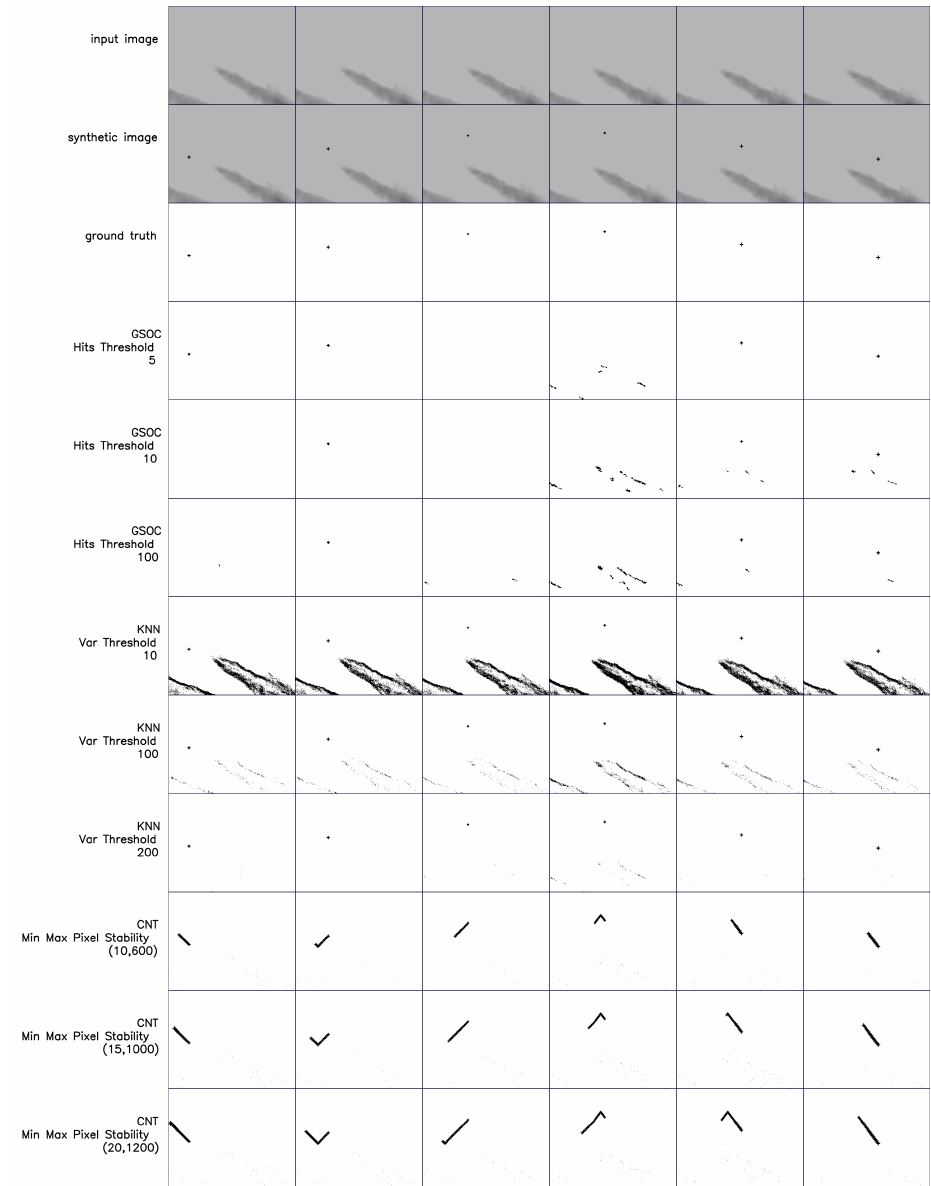
Figure 7. Influence of example algorithm parameters on the detection process (part 2) (CNT (CouNT), GSOC (Google Summer of Code 2017), KNN (K–Nearest Neighbor–based Background/Foreground Segmentation